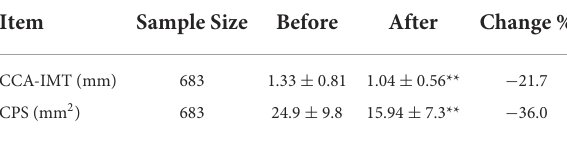
TABLE 4 Changes in the thickness of the intima-media of the common carotid artery (CCA-IMT, mm) and the size of the carotid plaque (CPS, mm 2 ) after 12 months of daily NK